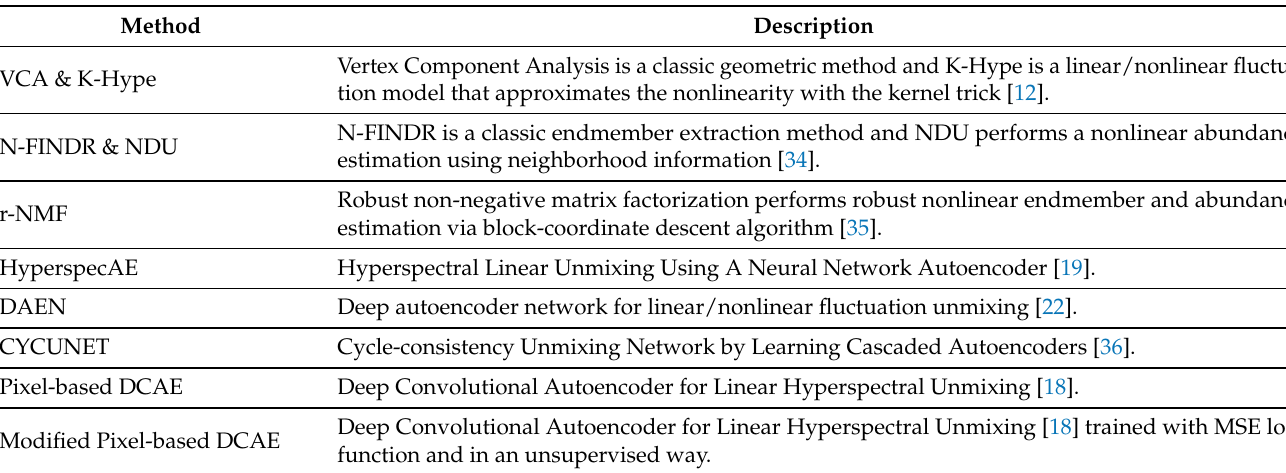
Table 2. Benchmark methods used for